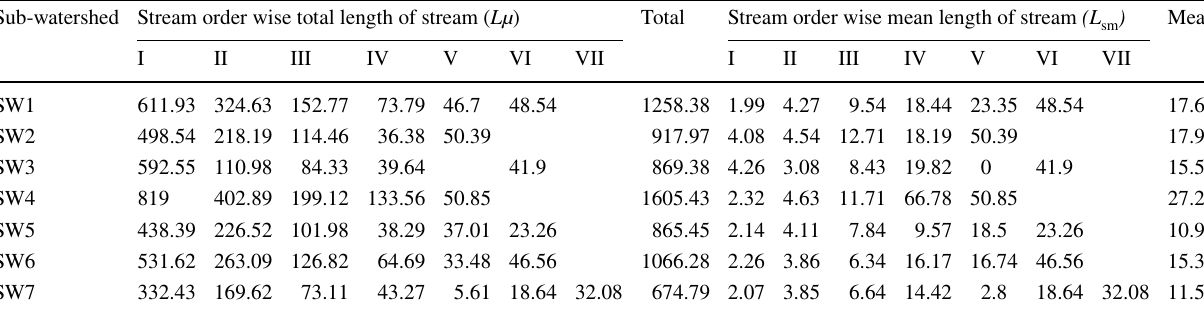
Fig. 4 Horton’s law of stream length ( x axis—stream order ( u ); y axis—log mean stream length Table 3 Total stream length ( Lµ ) and mean stream length ( L sm ) Sub-watershed Stream order wise total length of stream ( Lµ ) Total Stream order wise mean length of stream (L sm )